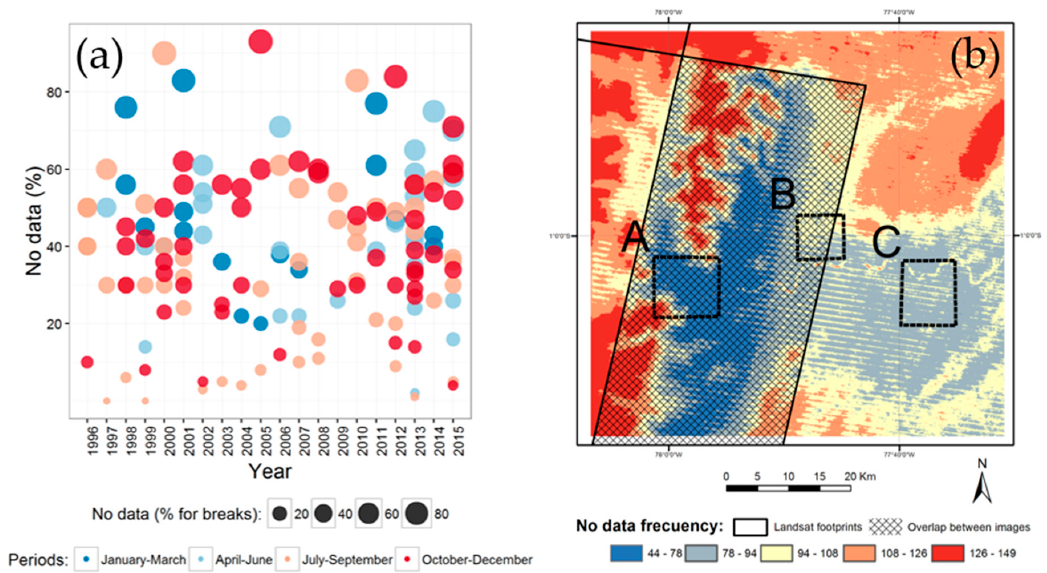
Figure 2. ( a ) No data percentage observed for period 1996–2015 for the subset of two Landsat footprints used (149 images selected). ( b ) Spatial distribution of no data frequency. Table 1. Acquisition parameters of the used images.